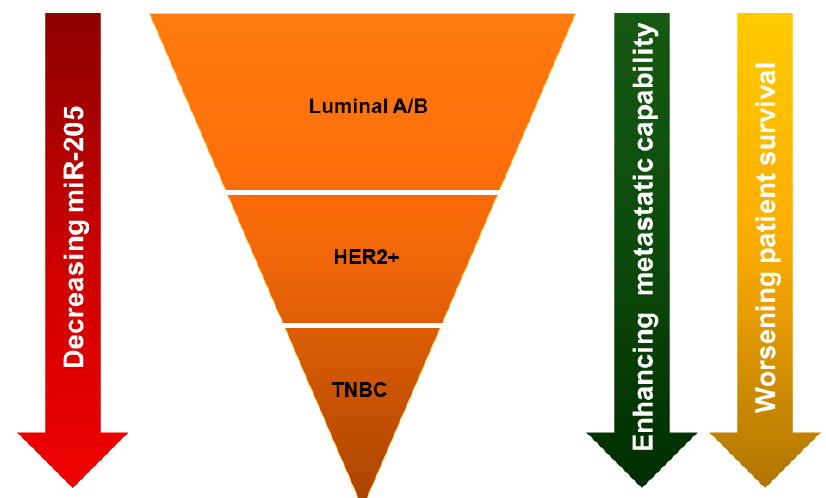
Figure 3. Differential expression levels of miR-205 among breast cancer subtypes. The expression of miR-205-5p is lower in HER2 + than luminal A/B, and triple negative breast cancer (TNBC) has the lowest miR-205-5p level compared with the other subtypes. Decreasing miR-205-5p expression level is associated with enhanced metastatic capability and worsening of patient survival.